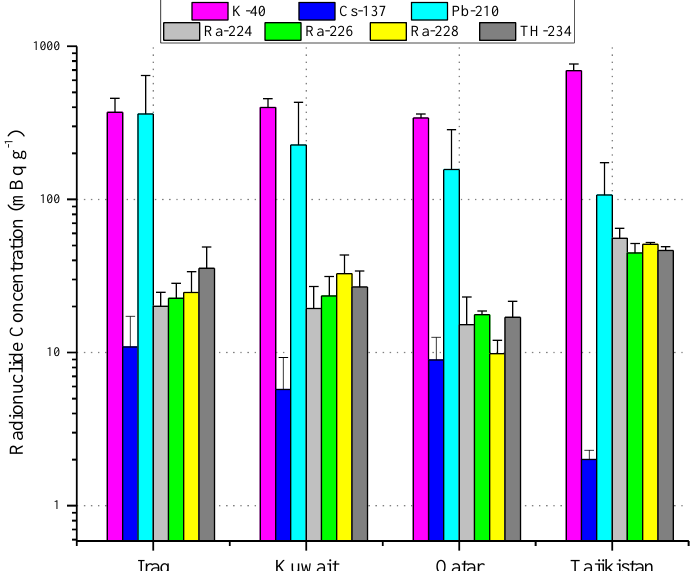
Figure 14. The average concentrations of the radionuclides in dust samples.